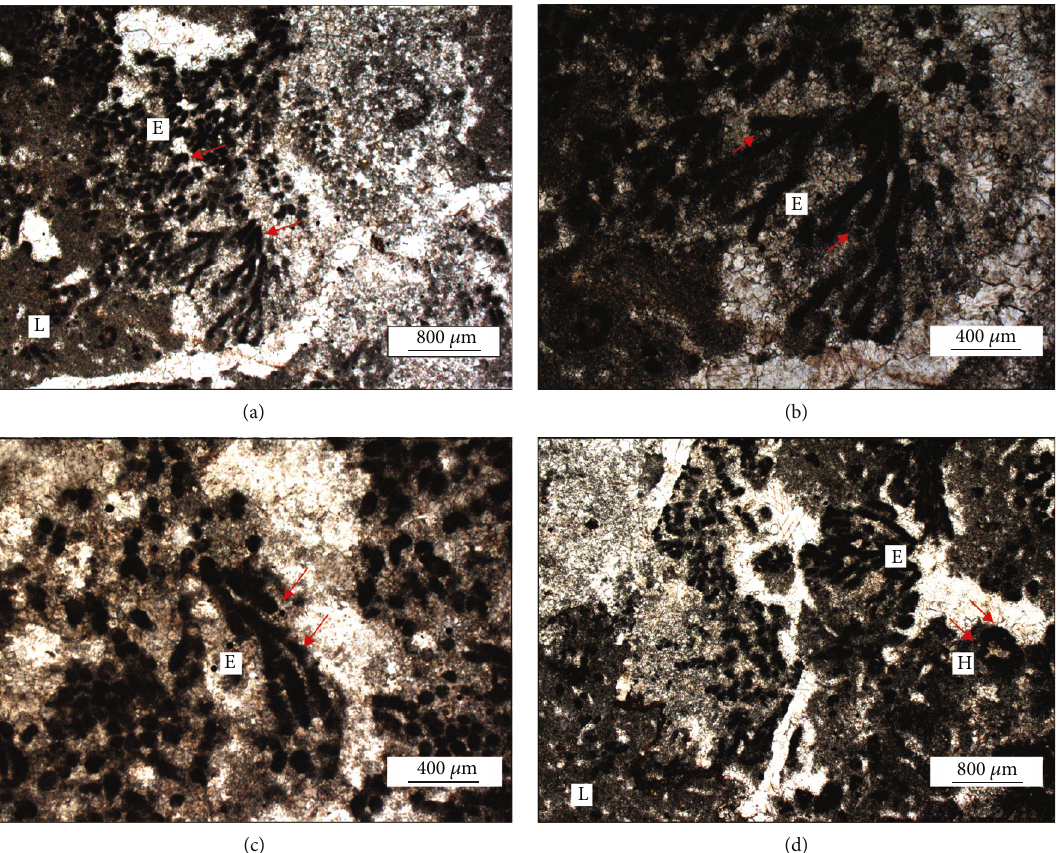
Figure 6: Micrographs of di ff erent types of Epiphyton in dendrolite of Zhangxia Formation, Houziyu Section, Shandong Province. (a, b) Typical large shrubby thallus micritic coarse branches Epiphyton (E; as shown by red arrows) forming micritic dendrolite communities. (b) A magni fi cation of the boxed area in (a), and most of the branches of Epiphyton are two branches. (c) Typical large shrubby fungi micritic-segmented branching Epiphyton (E) forming micritic dendrolite communities. (d) Typical micritic fi ne-branching Epiphyton (E) form micritic dendrolite communities with Hedstroemia (H; as indicated by the red arrow), possibly with a Lithocodium -like fabric